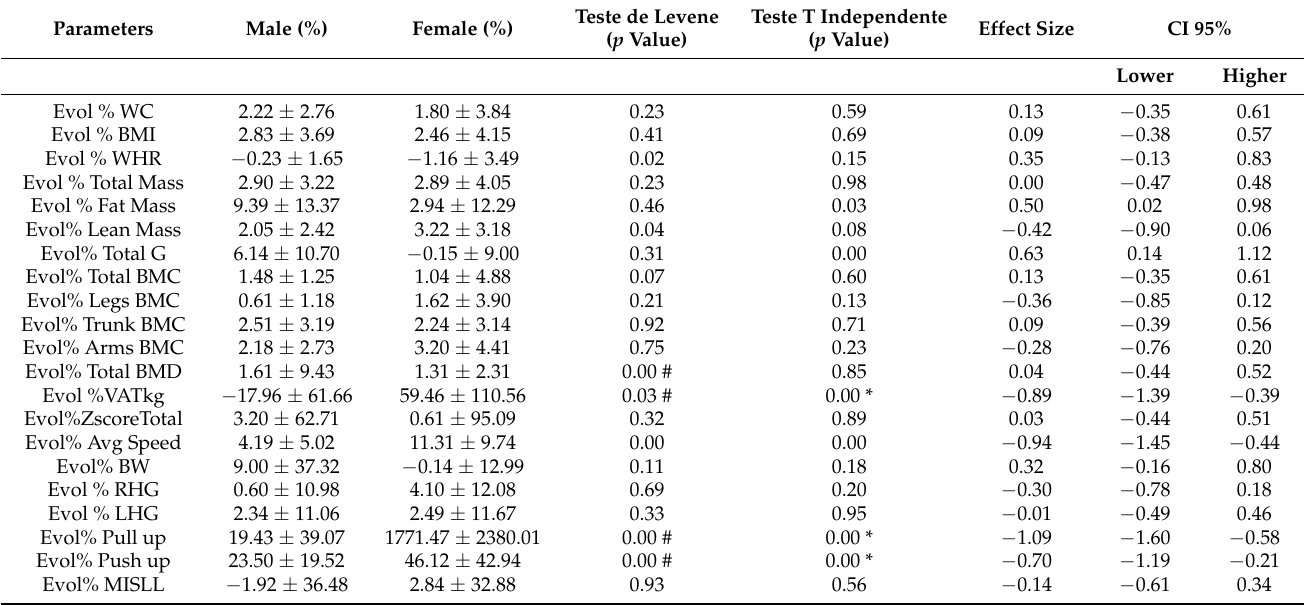
Table 4. Comparison, between males and females, of training effectiveness in anthropometric variables, body composition, bone mass and physical performance in the main components of physical fitness.